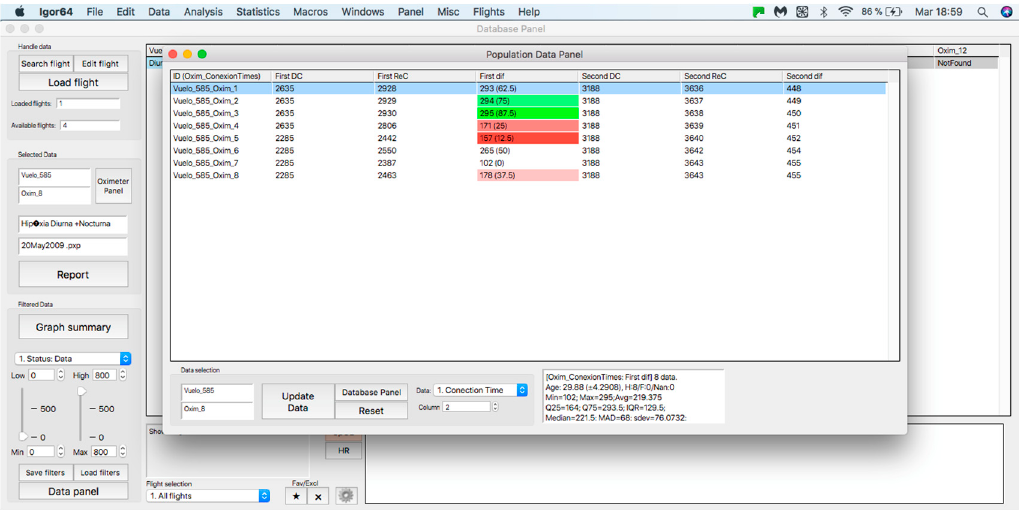
Figure 15. Display of the “sample data panel”.